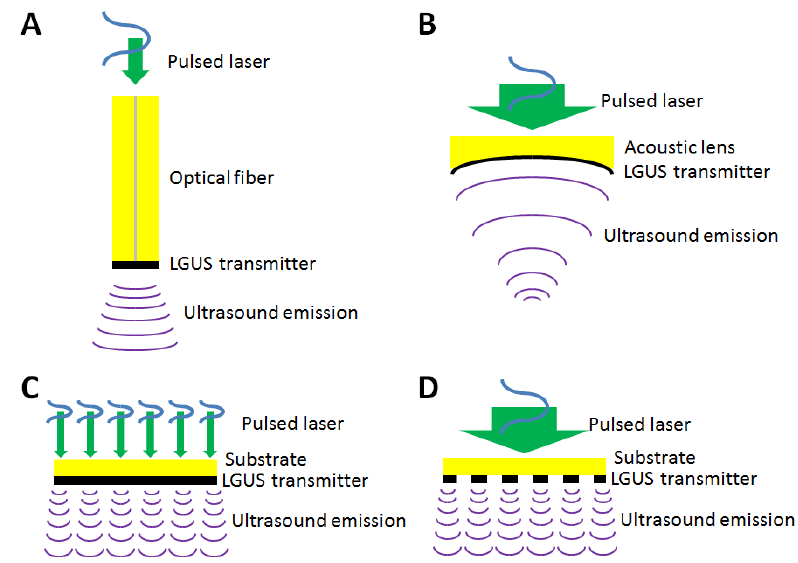
Figure 3. Schematics of: fiber-optic transmitter ( A ); focused transmitter ( B ); array transmitter with its pitch defined by spatially selective pulsed laser heating ( C ); and array transmitter with its pitch defined by spatially fabricated absorbers ( D ). Blue lines represent short laser pulses.